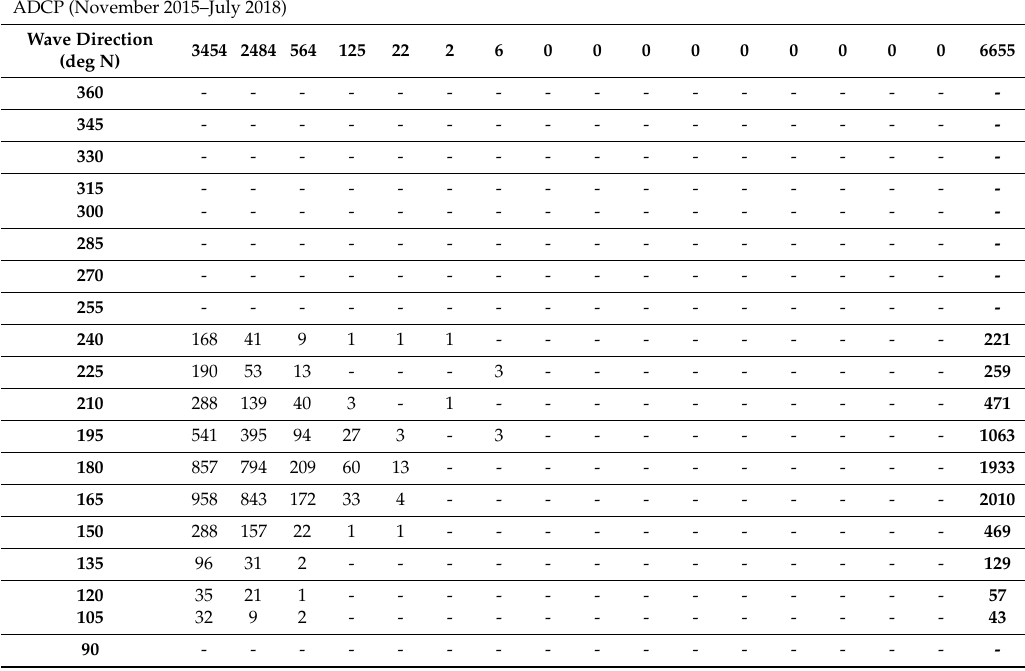
Figure 4. Seasonal wave rose diagrams for the HF radar and the ADCP entire dataset. The panels show the different seasons: ( a ) winter; ( b ) spring; ( c ) summer; and ( d ) autumn. The radial scale reports wave frequency, while each spoke is color-divided according to wave height ranges (see legend). Table 3. Joint frequency distributions of the wave measurements (Hs and θ ) recorded by the ADCP and the HF radars. Data were grouped in eight Hs classes of 0.50 m each, and in direction sectors with an angle of 15 ◦ . For each combination of Hs and θ values, the number of occurrences was